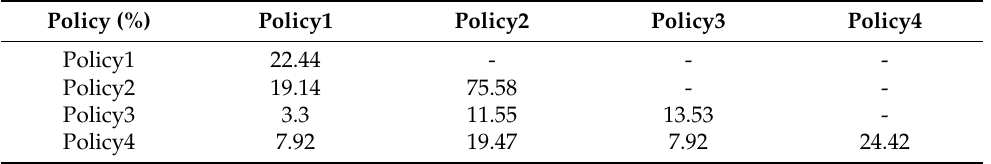
Table 5. Percentage of the rural households participating in each policy and the combination of policies. Policy (%) Policy1 Policy2 Policy3 Policy4 Policy1 22.44 -